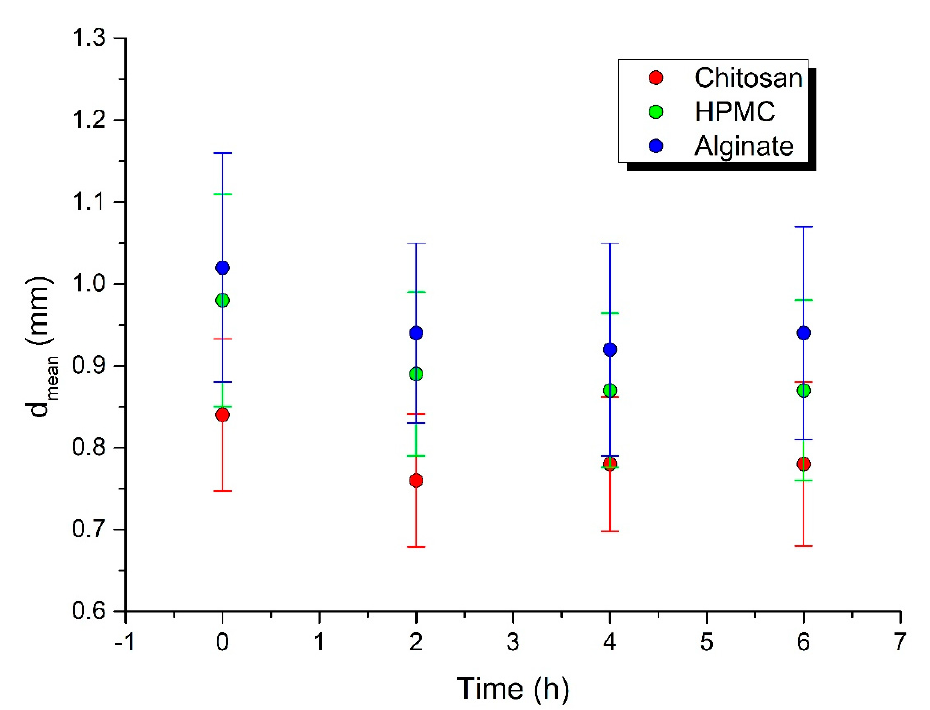
Figure 2. Mean pellet size change during dissolution testing.